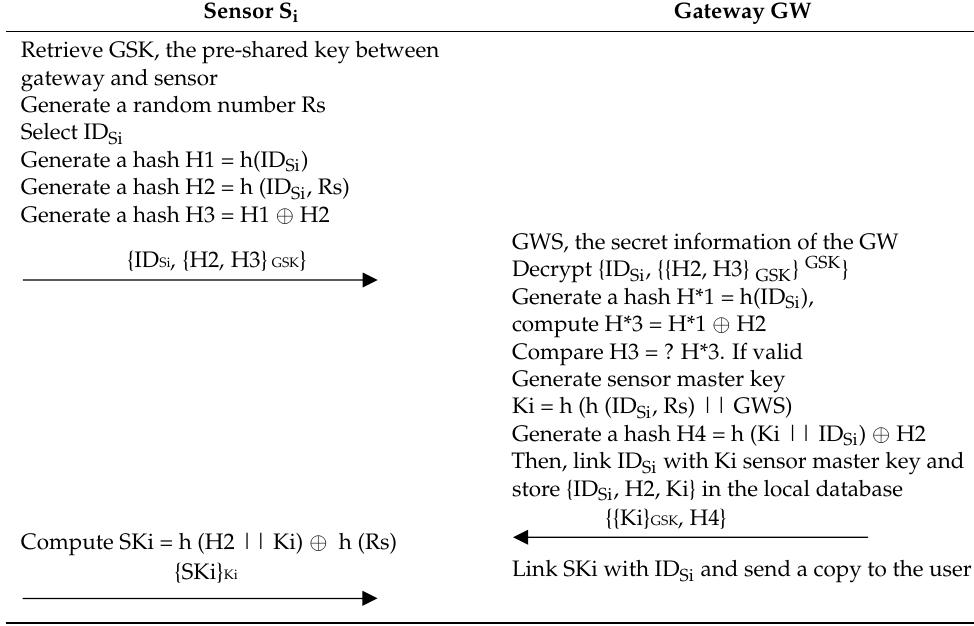
Table 3. Sensor node registration phase.